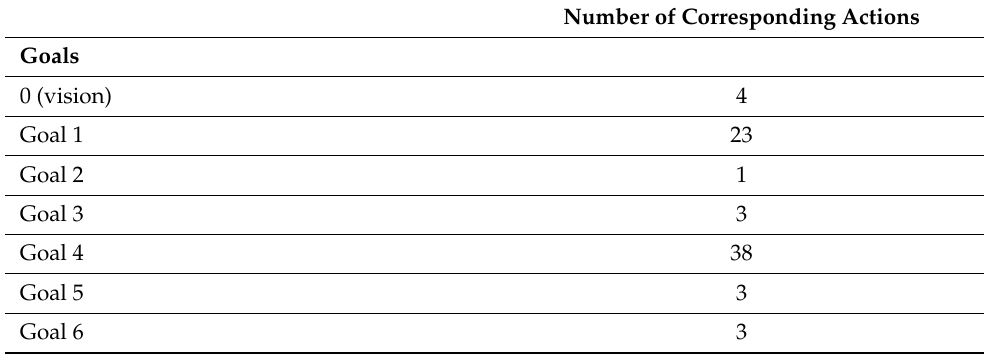
Table 4. Number of actions corresponding to each CFAN Goal and action